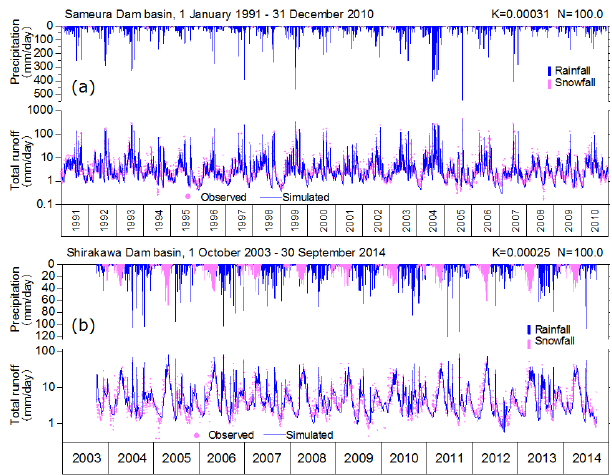
Figure 4. Examples of the observed and simulated hydrographs for the Sameura Dam basin (a) and the Shirakawa Dam basin (b)